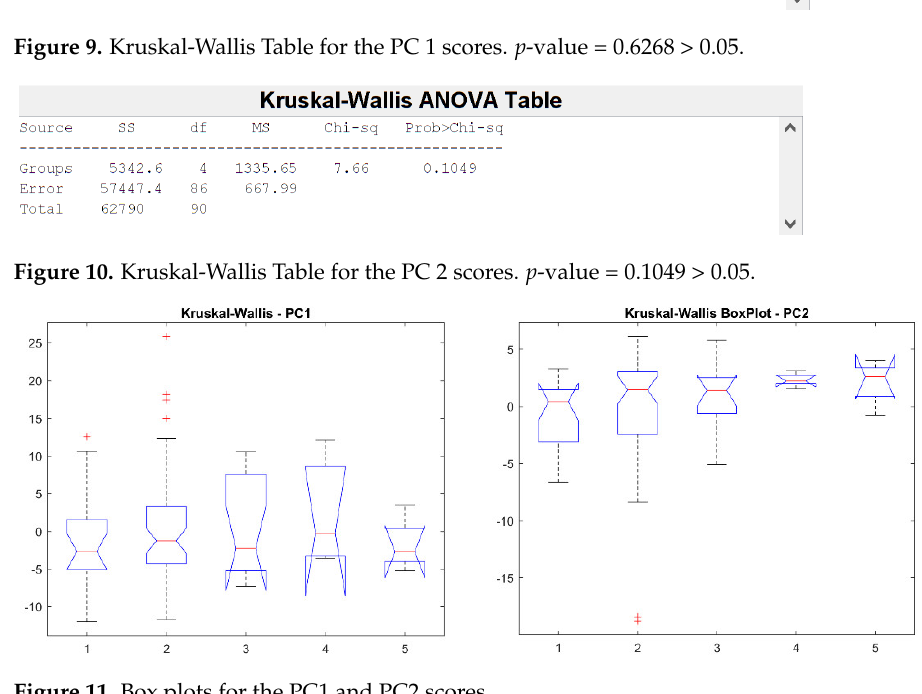
Figure 11. Box plots for the PC1 and PC2 scores.